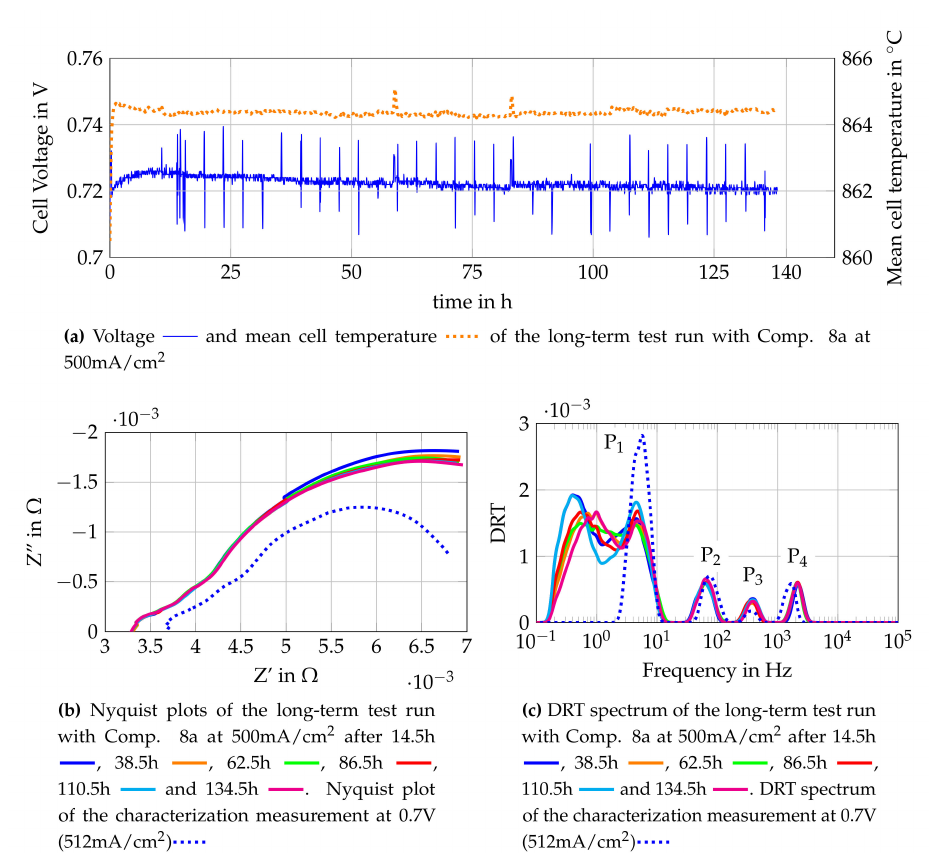
Figure 16. Monitoring data of the single cell fuelled with Comp. 8a at 500 mA/cm 2 . The new operating point (Comp. 8c) is shown in Table 4. As it can be seen,